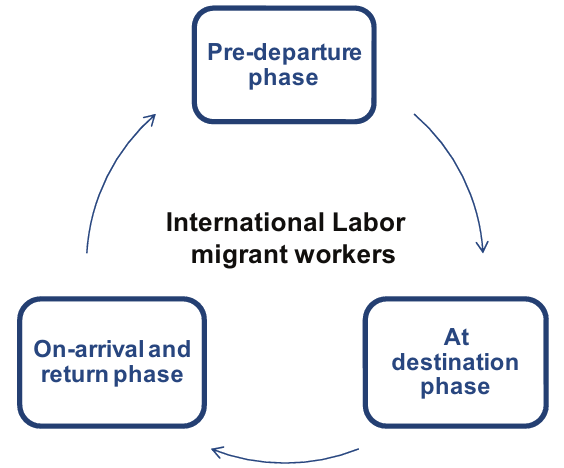
Figure 2. Identifying the ‘intervention space’ within phases of the labor migration cycle. Potential places for interventions (intervention space) in relation to labor